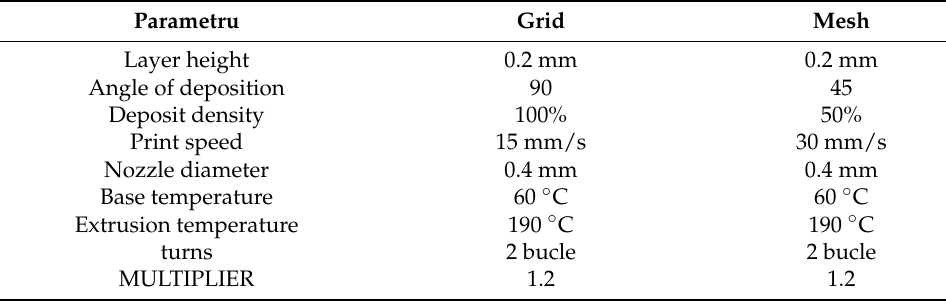
Table 4. Setting the parameters of the laboratory 3D thermal printer.